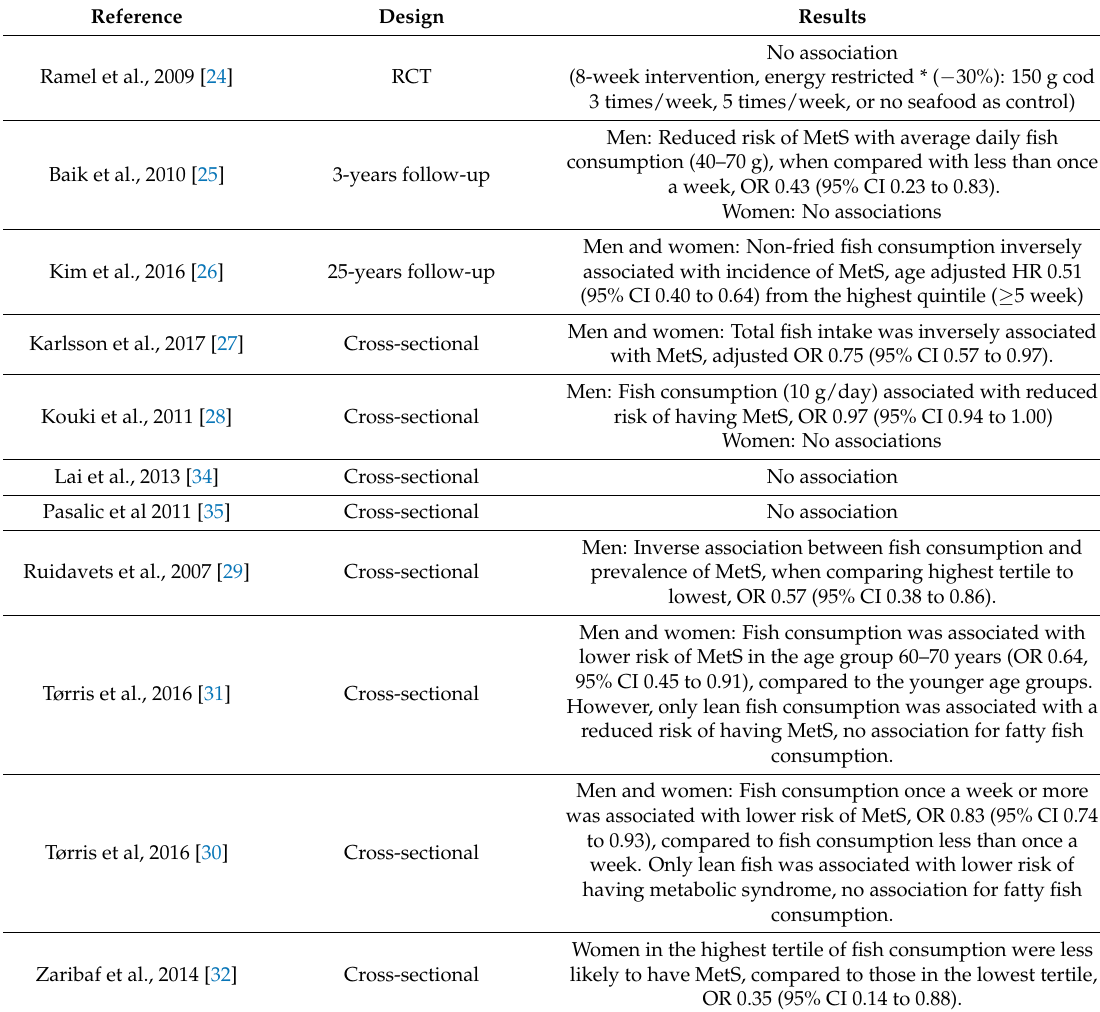
Table 2. Studies on fish consumption and metabolic syndrome